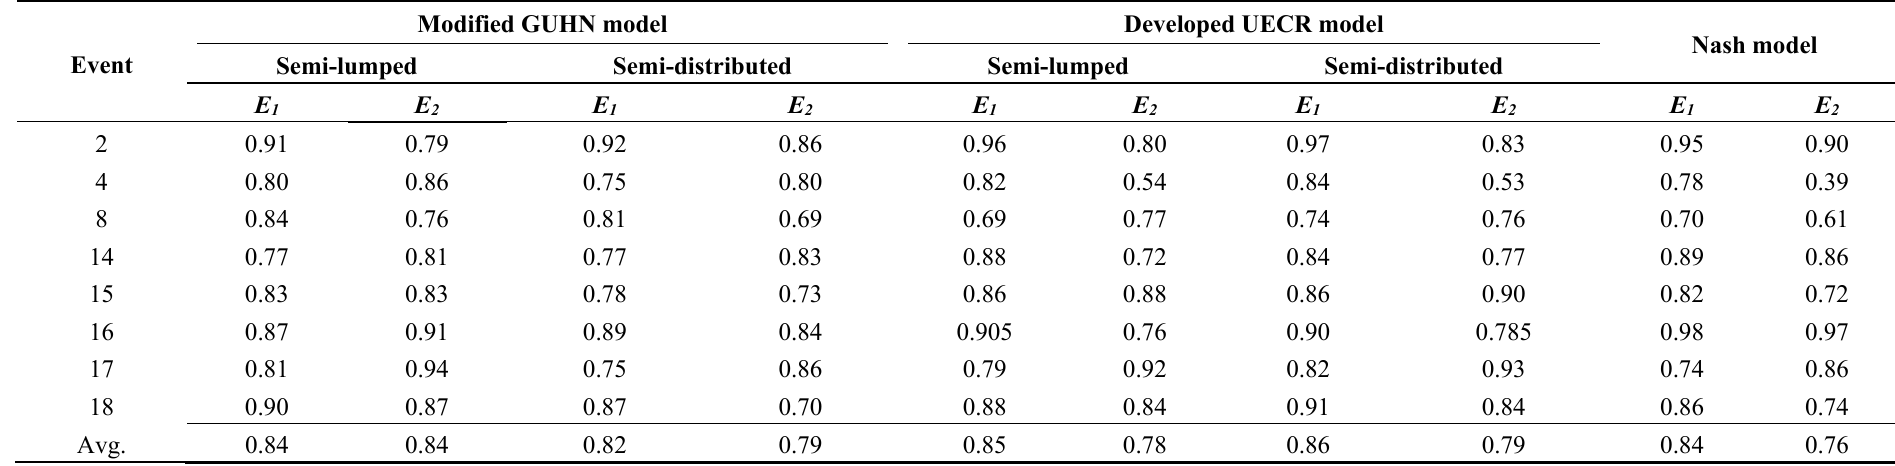
Table 6. Verification results of modified GUHN, developed UECR and Nash models